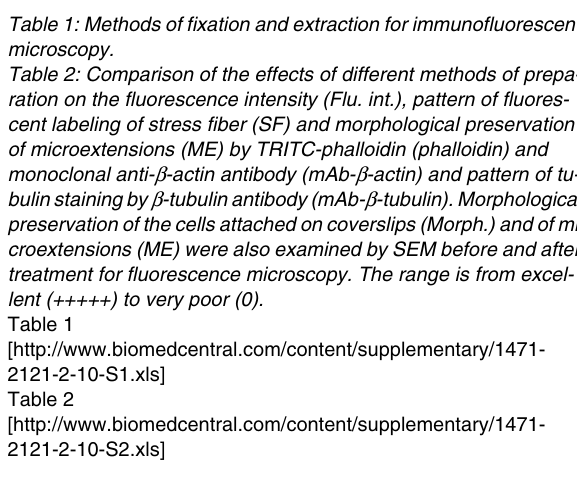
Table 2 [http://www.biomedcentral.com/content/supplementary/1471-